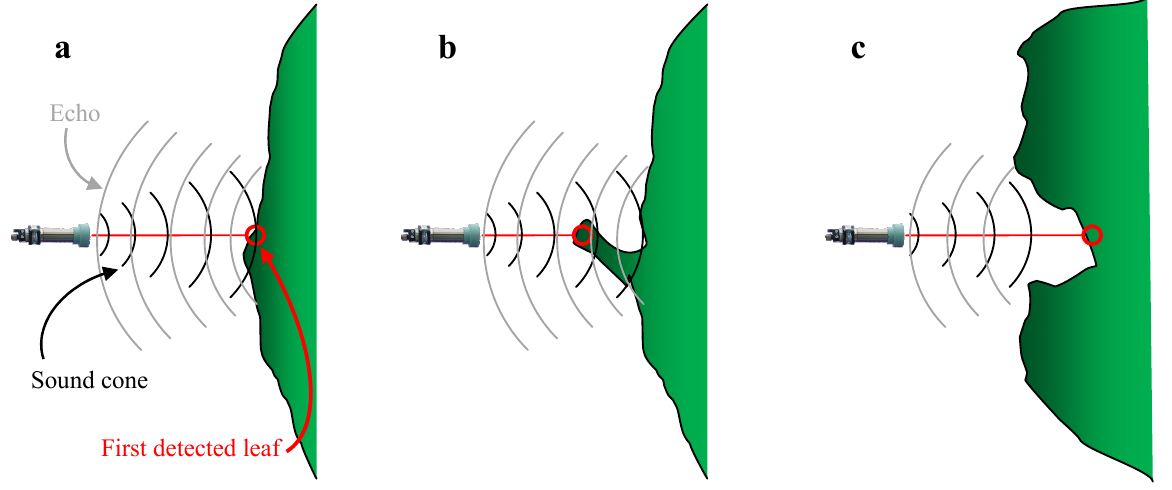
Figure 10. Interaction possibilities between ultrasonic waves and